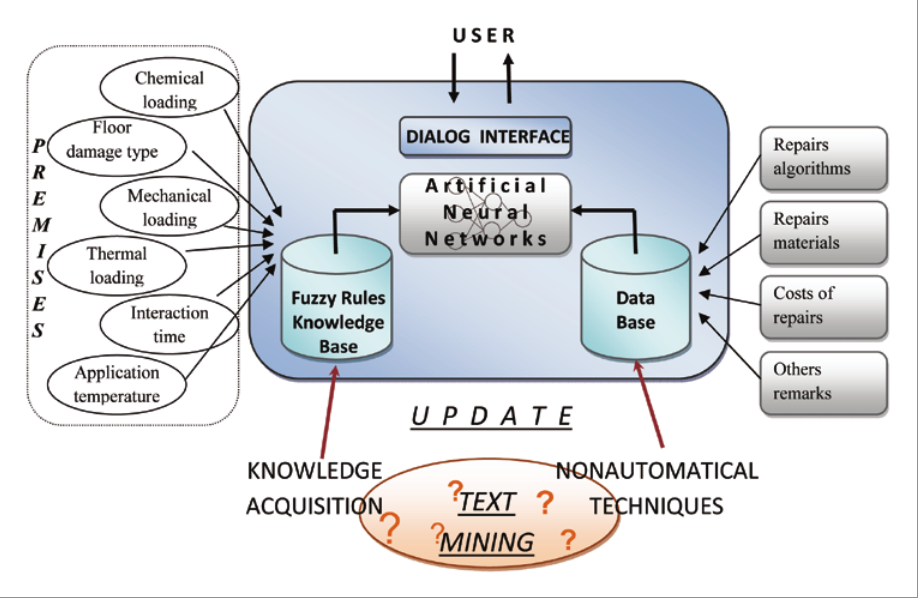
Fig. 1. Elements of the Hybrid Advisory System (HAS) for industrial floor